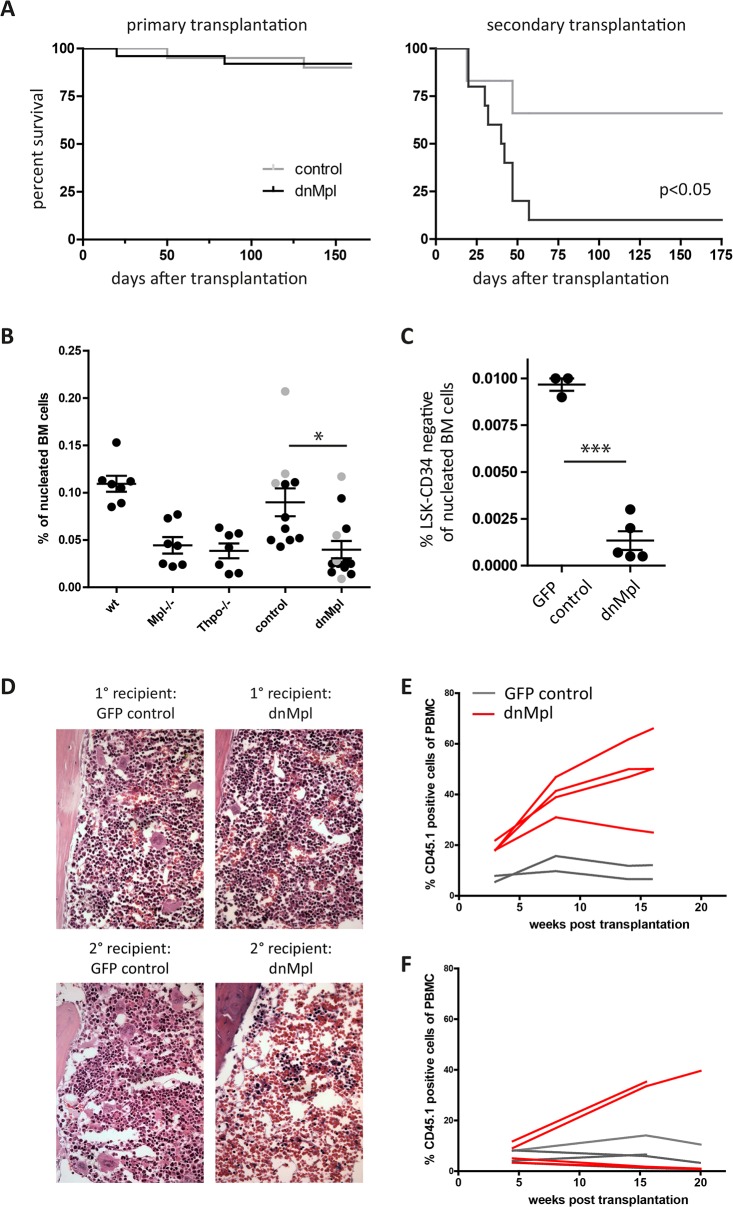
Impact of dnMpl expression on the HSC compartment.(A) Survival curve of primary transplanted mice of the dnMpl or the control groups (experiment 1–3, dnMpl n = 25, control n = 20). Of experiment three, the BM was transplanted into two secondary recipients each (3 dnMpl donors, 2 cd-dnMpl donors, 3 GFP control donors). There was no difference in survival in primary recipients but a significantly reduced survival of secondary recipients (10 dnMpl recipient mice and 6 control recipient mice, p<0.05). (B) Percentage of LSK cells in primary recipients (dnMpl and trCD34 control black filled circles, cd-dnMpl and GFP control in grey filled circles) or in steady state hematopoiesis (wt, Mpl-/-, Thpo-/-). (*p<0.05, Students t-test). (C) Percentage of LSK-CD34 negative cells in primary recipients of GFP control (n = 3) or dnMpl mice (n = 5) (***p<0.005, Students t-test). (D) Histological analysis of the BM of dnMpl and control transplanted mice. Primary (1°) dnMpl chimeric mice had reduced numbers and smaller megakaryocytes similar to Mpl-/- mice. Secondary dnMpl recipient mice (2°) had a hypocellular BM in agreement with the symptoms of BM failure. BM sections were Hematoxylin/Eosin stained and microscopic images were taken at 200x magnification. (E) CD45.2 wildtype C57Bl/6 mice were transplanted with dnMpl, cd-dnMpl or GFP control transduced CD45.2 wildtype lin- BM cells (experiment 3). 19 weeks after the first transplantation, two dnMpl, two cd-dnMpl and two GFP mice were infused with a second graft of 2x107 CD45.1 whole BM cells without further conditioning. The chimerism of CD45.1 in the blood leukocytes was analyzed over a period of 16 weeks. dnMpl conditioned mice allowed the engraftment of a second wt graft without further conditioning. (F) In experiment 5, CD45.2 wildtype C57Bl/6 mice were transplanted with dnMpl or GFP control transduced CD45.2 wildtype lin- BM cells, however, with intended lower chimerism. 19 weeks after the first transplantation mice were given a second graft of 2 x107 CD45.1 whole BM cells without further conditioning. The chimerism of CD45.1 in the blood leukocytes was analyzed over a period of 20 weeks. While the two mice exhibiting the highest percentage of dnMpl expression (4 and 14%) allowed stable engraftment of the second graft, the mice with < 1% dnMpl expression in the periphery failed to do so and presented with the low engraftment levels similar to the four GFP control mice.